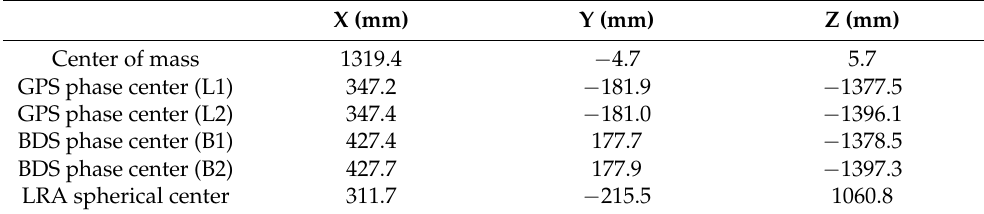
Table 1. Coordinates of the center of mass, GPS and BDS antenna phase centers and LRA spherical center in the SBF.